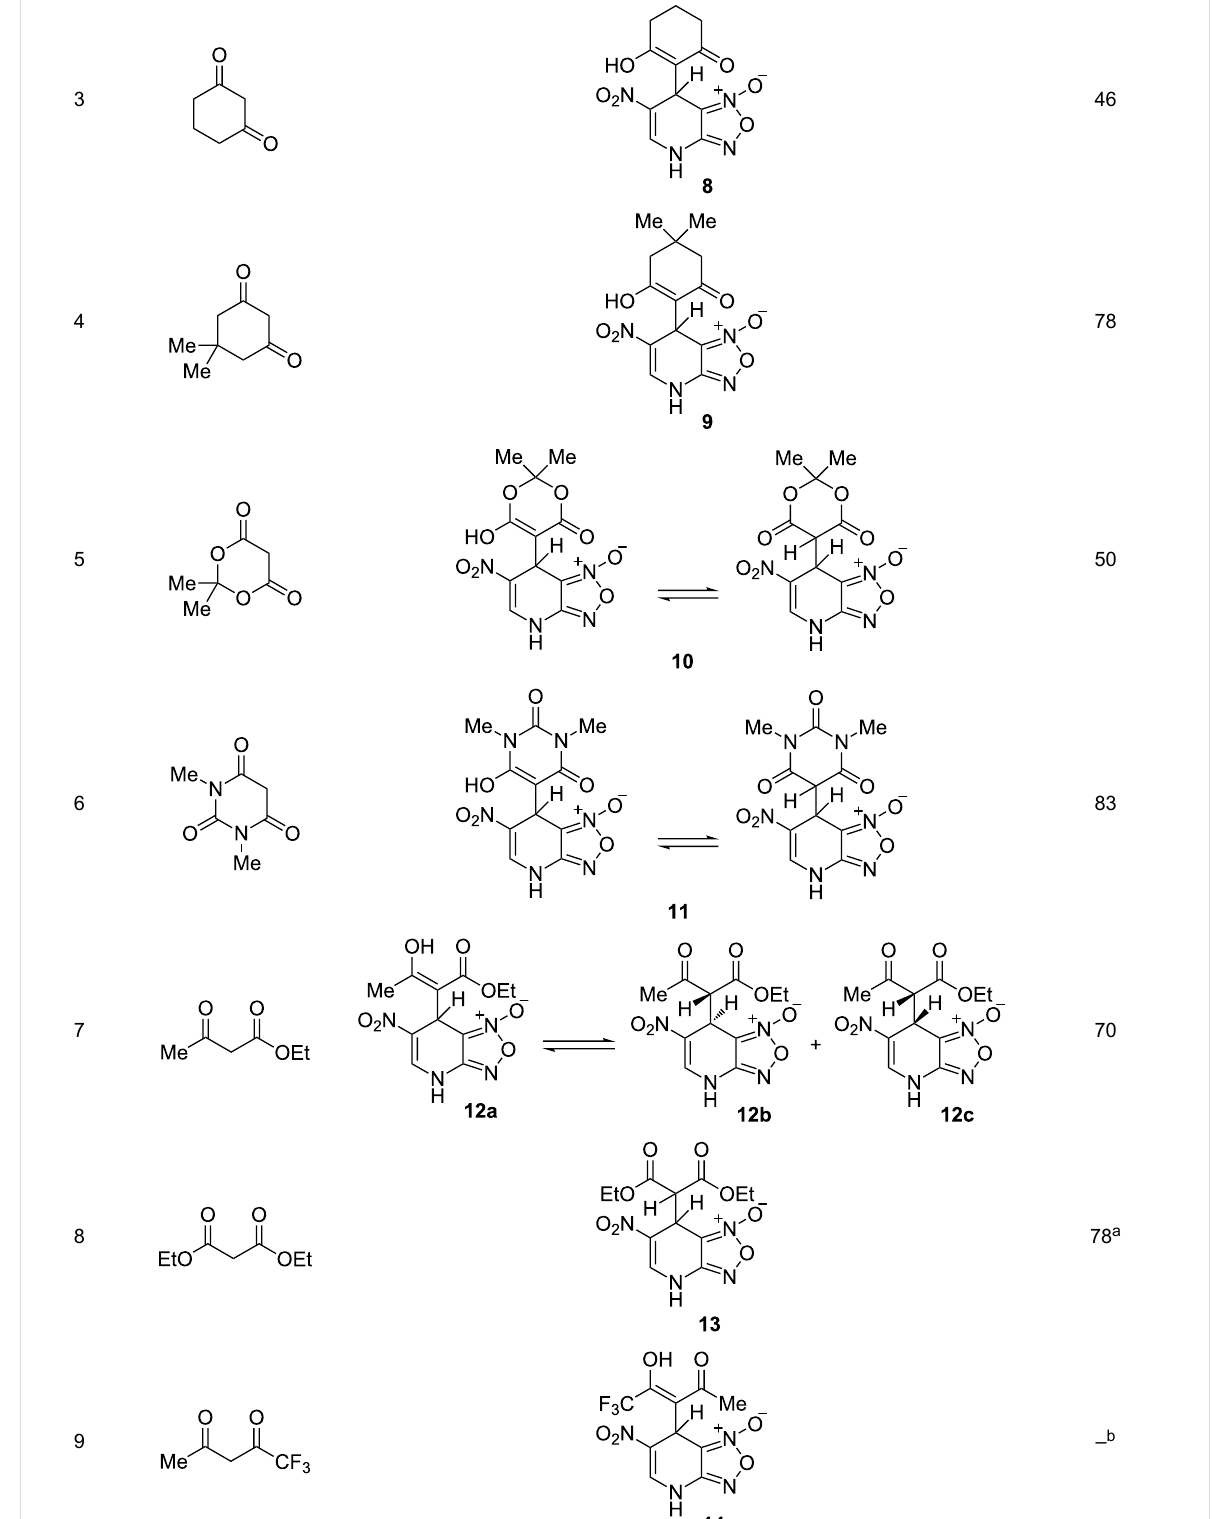
Table 1: Reactions of ANBF with β -dicarbonyl compounds.